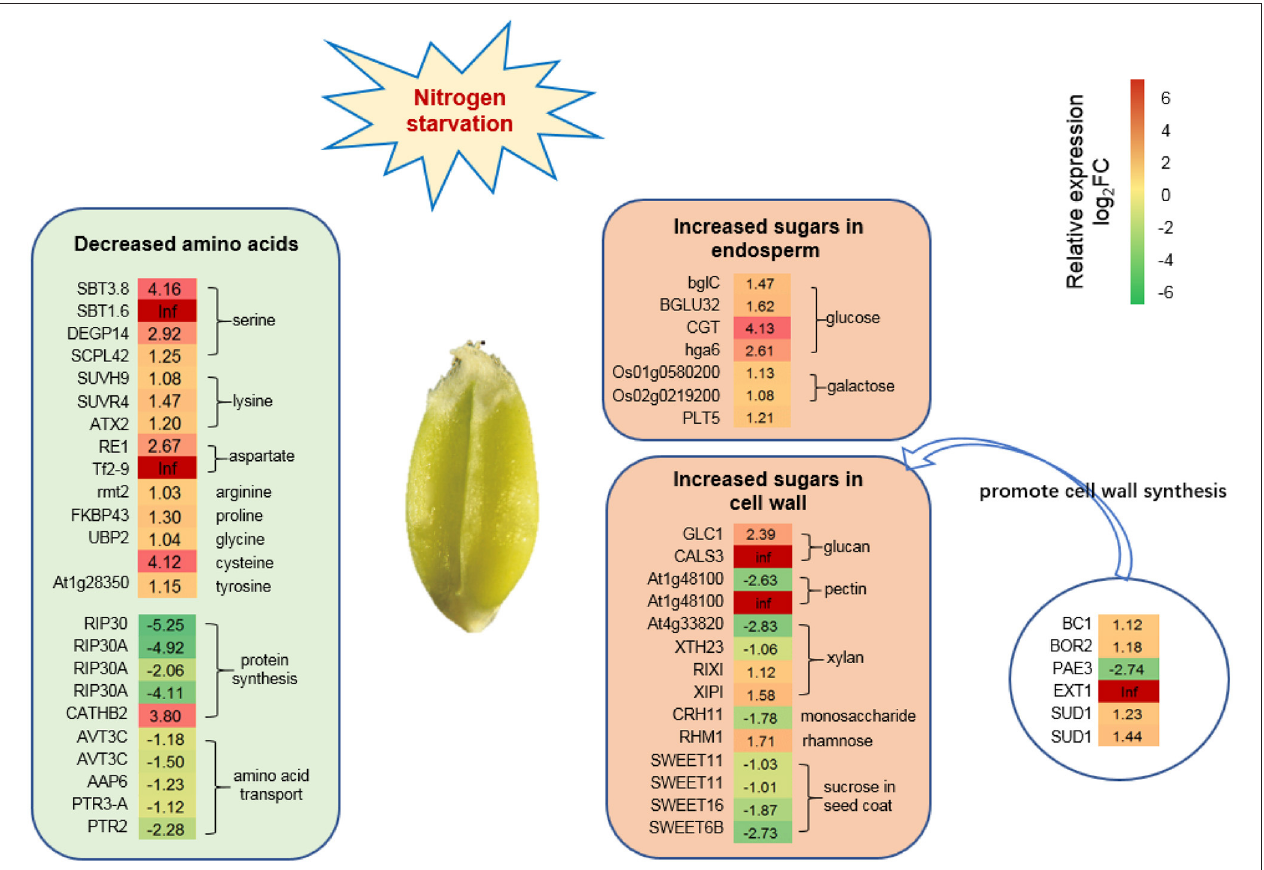
FIGURE 6 | DEGs related to amino acid and sugar synthesis under N starvation conditions. Twenty-four DEGs associated with amino acid synthesis decreased the level of amino acids. Twenty-one DEGs associated with sugar synthesis increased the sugar level in the endosperm and episperm (mainly representing the cell wall). Six DEGs were significantly expressed that promote cell wall synthesis. The relative expression levels as described by log 2 FC (FC is the fold change of RPKM means N0/Nck) are represented by a color gradient from low (green) to high (red). Under N-starvation conditions, the DEGs with log 2 FC > 0 represent up-regulated expression, log 2 FC < 0 represents down-regulated expression, and log 2 FC = 0 represents unchanged